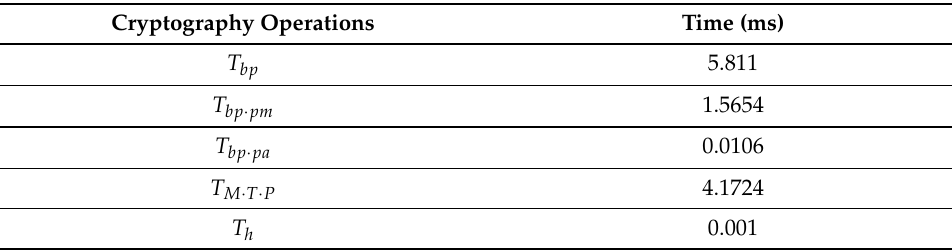
Table 4. The single cryptographic operation time.